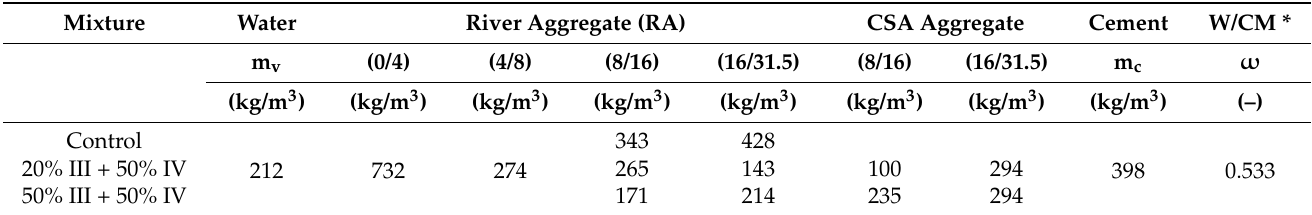
Table 5. Concrete mix design